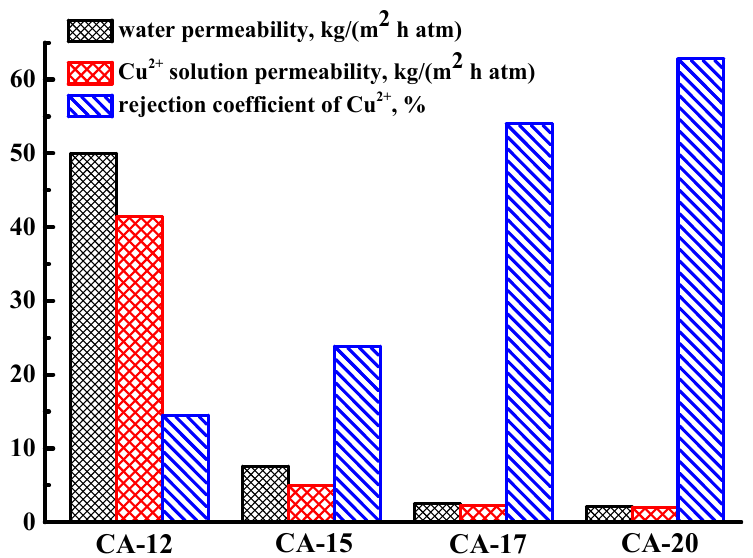
Figure 1. Transport properties of CA-based membranes prepared from different casting solution concentrations in nanofiltration of water and a model Cu 2+ solution.